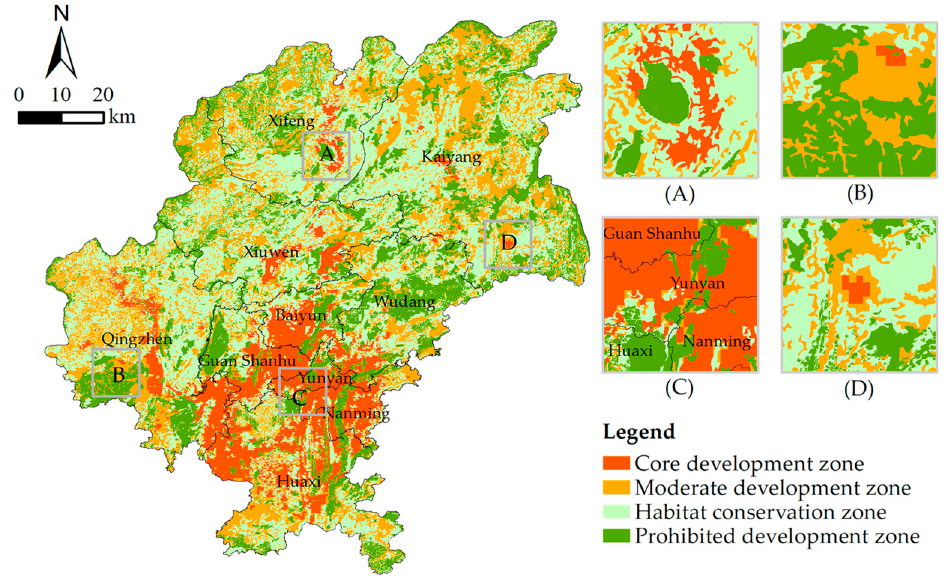
Figure 10. Spatial zoning results of Guiyang city.